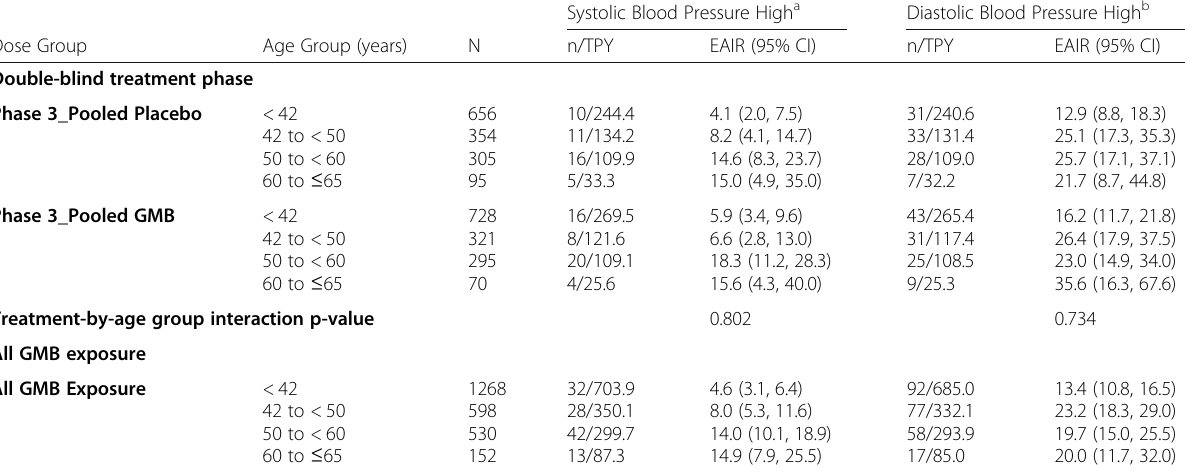
Systolic Blood Pressure High a Diastolic Blood Pressure High b